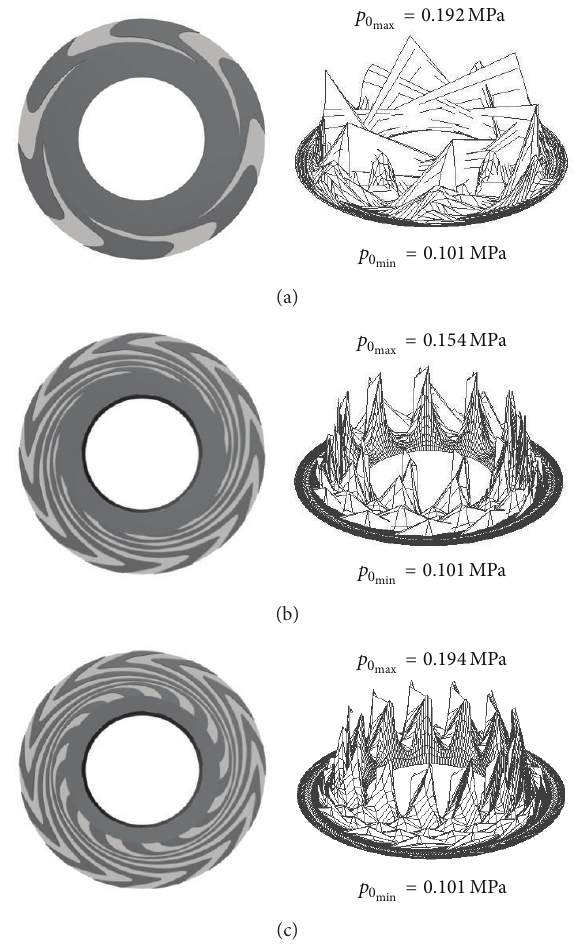
Figure 5: Groove geometry and pressure distribution of optimized oil lubricated bearings. (a) Optimized at 10,000rpm, ℎ 𝑎 = 2 𝜇 m, (b) optimized at 10,000rpm, ℎ 𝑎 = 3 𝜇 m, (c) optimized at 10,000 rpm, = 4 𝜇 ℎ 𝑎